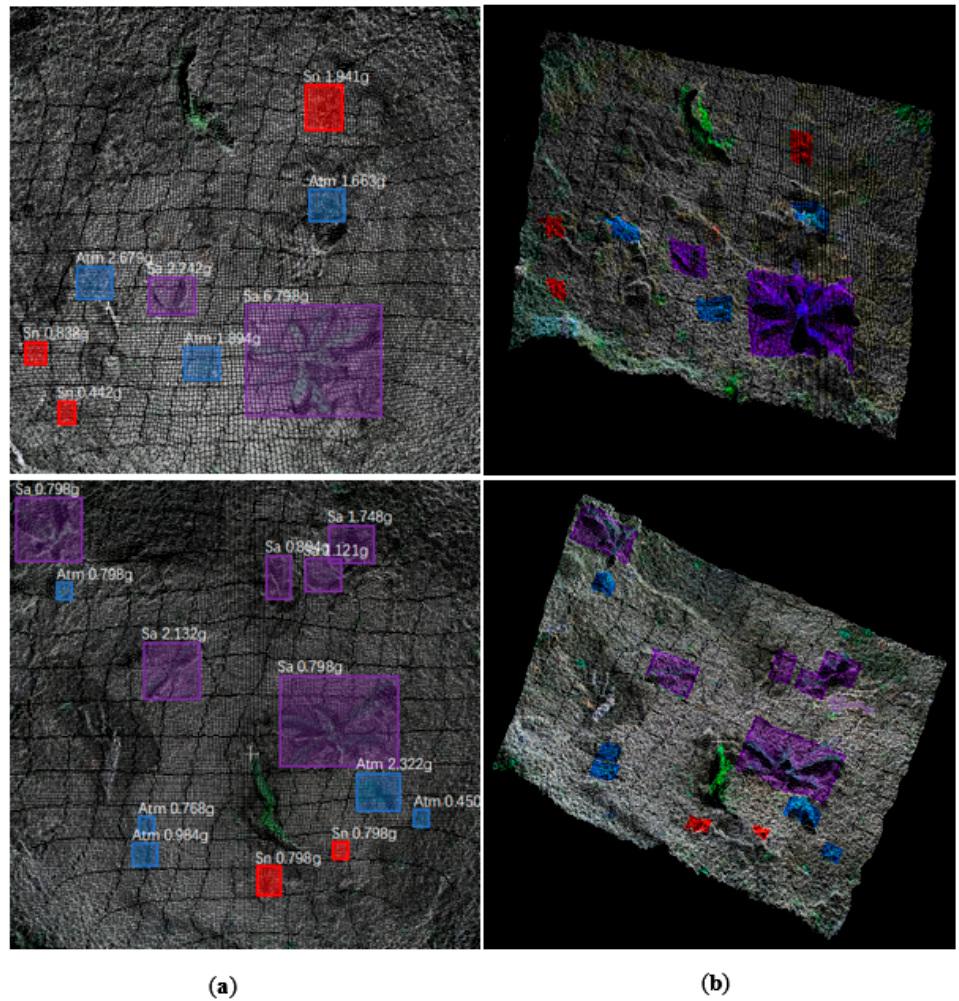
Figure 10. Weed detection and fresh weight prediction results. ( a ) is an overhead view of the weed detection results, and ( b ) is a side view. Among them, Abutilon theophrasti Medicus is abbreviated as Atm , Sonchus arvensis is abbreviated as Sa , and Solanum nigrum is abbreviated as Sn .